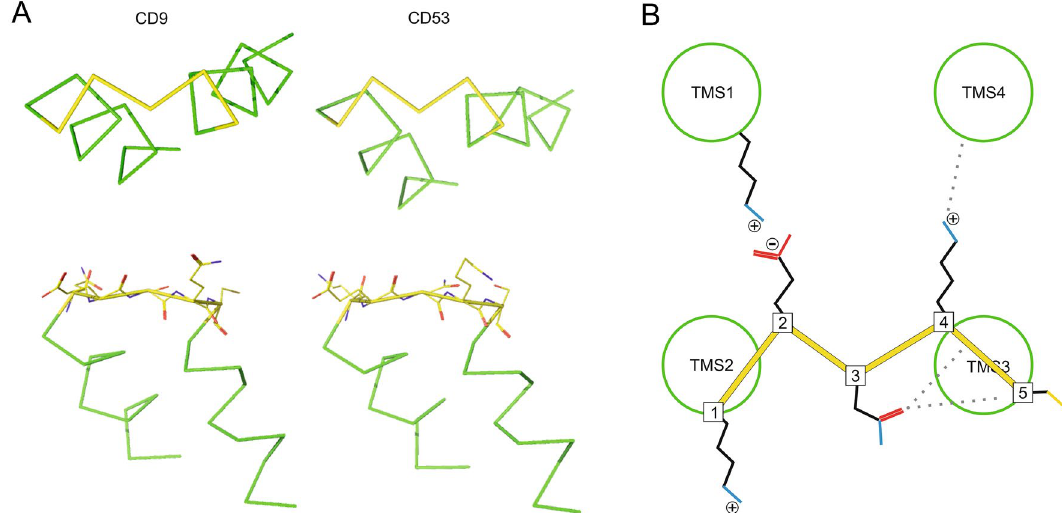
Figure 3. The SIL core forms an M-motif. ( A ) Illustration of the M-motif (yellow) and attached helical structure (green) based on the published crystal structures of CD9 (PDB 6K4J; left) and CD53 (PDB 6WVG; right). Upper panels, top view from the intracellular side. Lower panels, side views. TMS2 (left) and TMS3 (right) are connected to the M-motif and form with the other two TMSs a membrane-embedded funnel (for the complete structures see Fig. S4). The symmetric embedding of the funnel (see OPM database) aligns the M-plane parallel to the membrane. The side view illustrates that the M-motif backbone bonds are co-planar and that, with the exception of position 4, all residues lay roughly in the M-plane. ( B ) Summary of interactions between consensus sequence amino acids that were identified in the crystal structures of CD9 and CD53. Position 2: salt-bridge between glutamate and lysine of the N-terminus in CD9 (for sequence alignment of the N-termini see Fig. S6); in CD53 similar arrangement but distance is too long for a salt-bridge (for details see Fig. S4). Position 3: interactions between the carbonyl-group of an asparagine with the backbone of TMS3 in CD53 (Fig. S4). Position 4: interaction between the lysine side chain and the backbone of TMS4 in CD53 (Fig. S4B). In the stick representation of the side chains, red, blue and yellow indicate oxygen, nitrogen and sulphur, respectively. ⊕ / ⊖ indicate amino acid residue charges at physiological pH. The scheme was created using CorelDRAW 2019 (www. corel. com) and the crystal structure images were created using PyMOL 2.5 (https:// pymol.